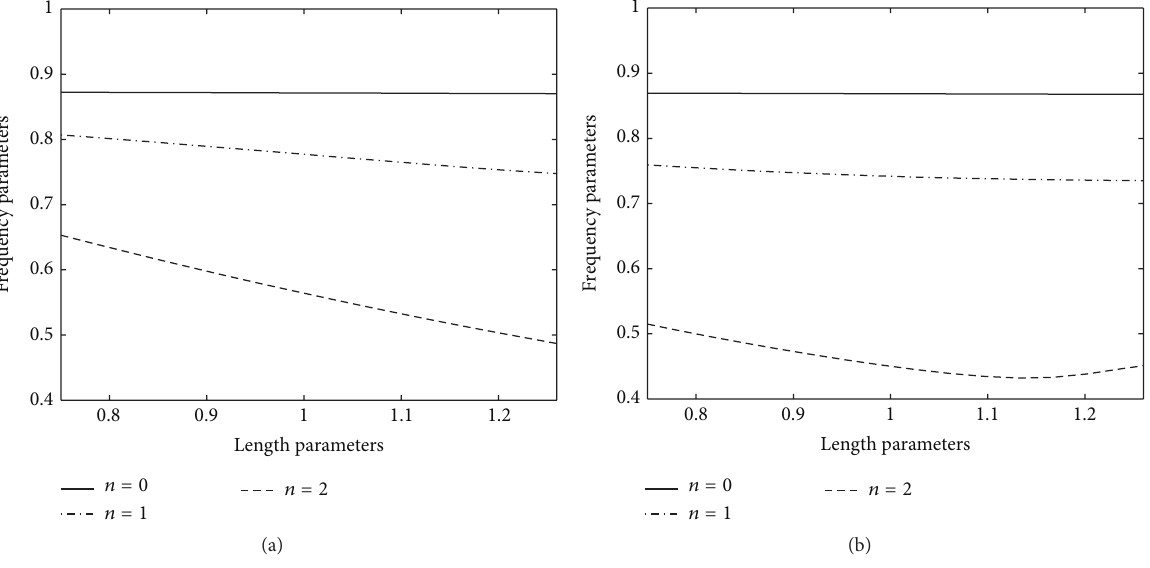
Figure 7: Natural frequency parameters for the conical shell with variation of length to radius ( 𝑎 = 45 ∘ , ℎ/𝑅 2 = 0.01 ; (a) C-C, (b) F-C).